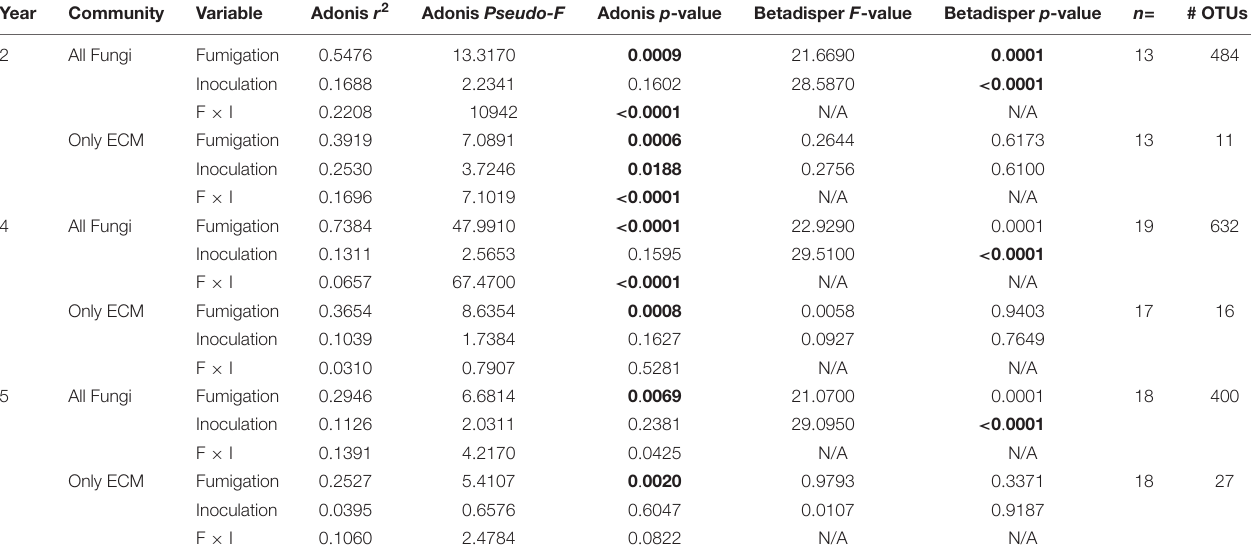
TABLE 3 | Ecological statistics, sample size, and number of operational taxonomic units (OTUs) for all years (year 2 = 2015, year 4 = 2017, year 5 = 2018) of the fumigation and inoculation experiment that was conducted at the Tift experimental orchard in Tift County, Georgia, United